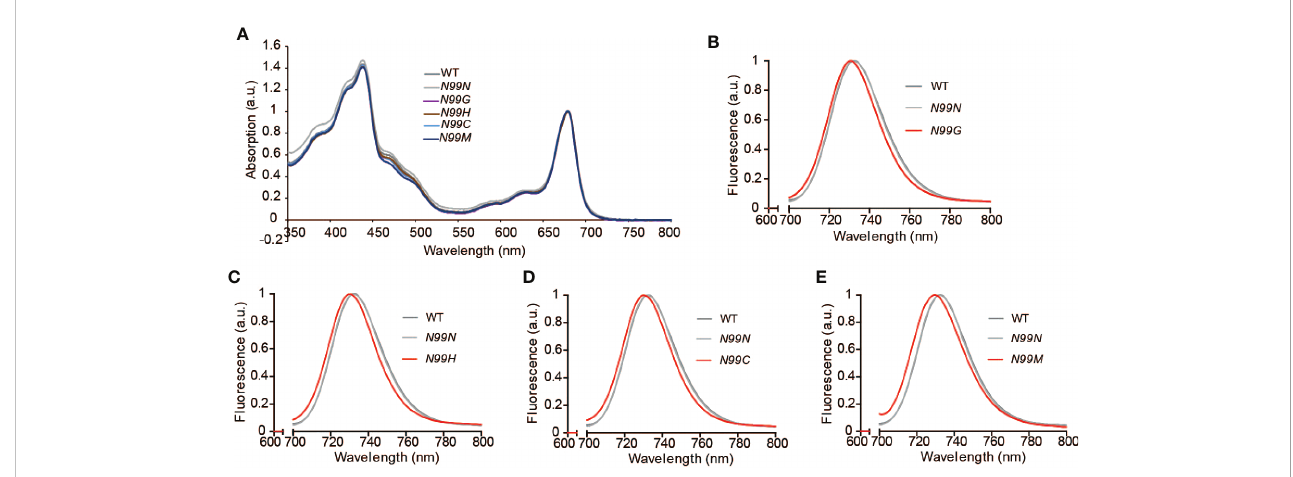
FIGURE 4 Spectroscopic properties of PSI-LHCI isolated from the WT and N99 point mutant lines. (A) Absorption spectra at room temperature of the WT and N99 point mutant lines. The spectra were normalized, with their maximal absorption in the Qy region set to 1. (B-E) Low-temperature (77K) fl uorescence emission spectra of PSI-LHCI complexes (Band 3) isolated from the WT (dark grey solid line), the control line 35S:LHCA4 ( N99N ) (light gray solid line), and the N99 point mutant lines 35S:LHCA4 ( N99G ) (B) , 35S:LHCA4 ( N99H ) (C) , 35S:LHCA4 ( N99C ) (D) , and 35S:LHCA4 ( N99M ) (E) , shown as red solid lines. The excitation wavelength was 440